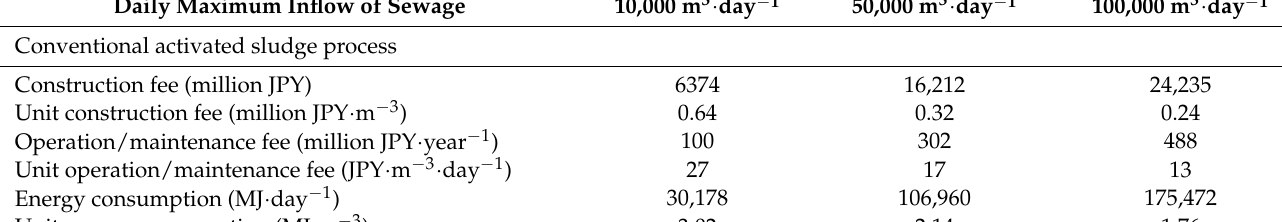
Table 2. Estimation of construction and operation/maintenance fees and unit energy consumption of conventional activated sludge process and advanced anaerobic–anoxic–oxic process (excluding incinerator) [32]. Daily Maximum Inflow of